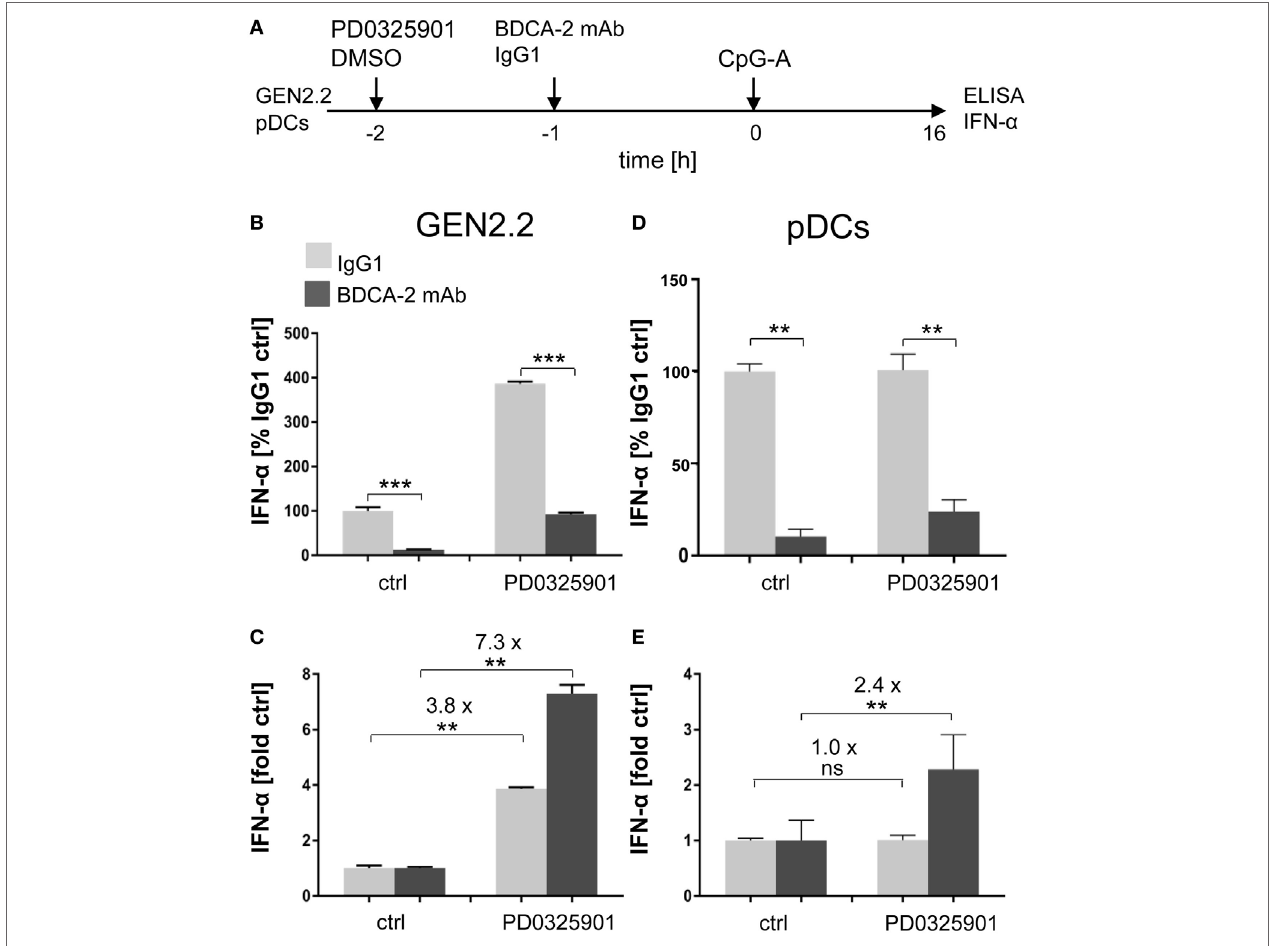
FigUre 3 | Effect of MEK1/2 inhibitor PD0325901 on the blockade of IFN- α production by ligation of regulatory receptors of GEN2.2 cells or primary plasmacytoid dendritic cells (pDCs) with blood dendritic cell antigen 2 (BDCA-2) mAb. (a) Experimental outline. GEN2.2 cells separated from MS-5 feeder cells or primary pDCs were incubated with the MEK1/2 inhibitor for 1 h before stimulation with BDCA-2 mAb and CpG-A. After a 16 h culture, the IFN- α production was determined in the cell-free supernatants by ELISA. (B,D) The IFN- α production was normalized to the level induced by CpG-A in the presence of IgG1 and in the absence of the MEK1/2 inhibitor. (c,e) The same data showing the IFN- α production in panels (B–D) were normalized to the level induced by CpG-A in the absence of the MEK1/2 inhibitor. The data show mean ± SEM of (B,c) six independent experiments with GEN2.2 cells, **, p < 0.01; ***, p < 0.001; two-tailed Mann–Whitney test, and (D,e) nine independent experiments with primary pDCs from different healthy donors, **, p < 0.01; two-tailed paired Wilcoxon